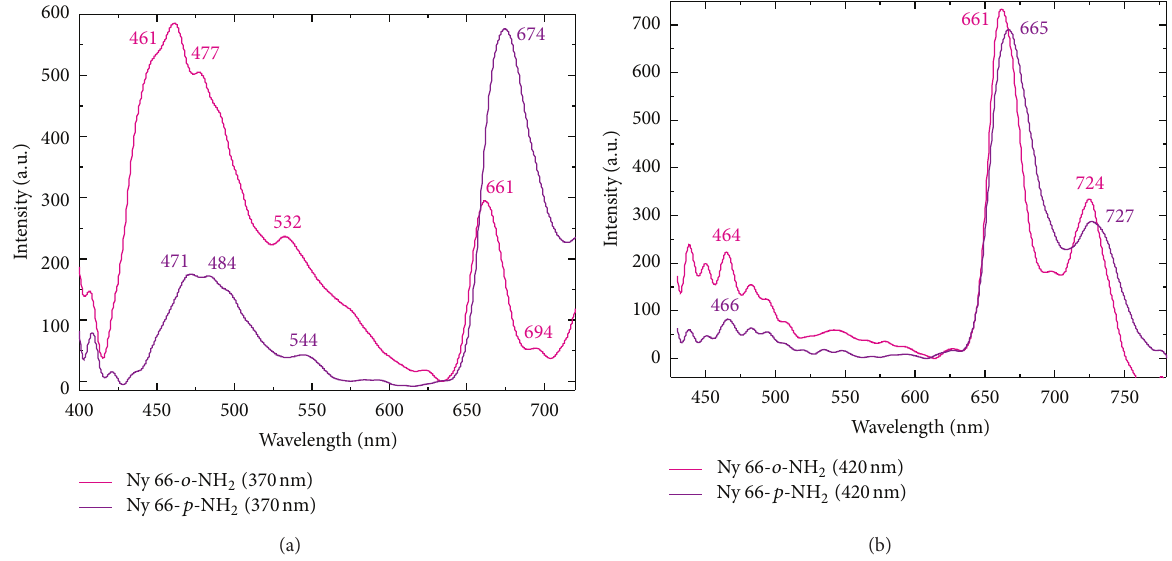
Figure 10: Fluorescence spectra obtained with excitation radiation of 370 nm (a) or 420 nm (b) of the Ny 66- o -NH 2 and Ny 66- p -NH 2